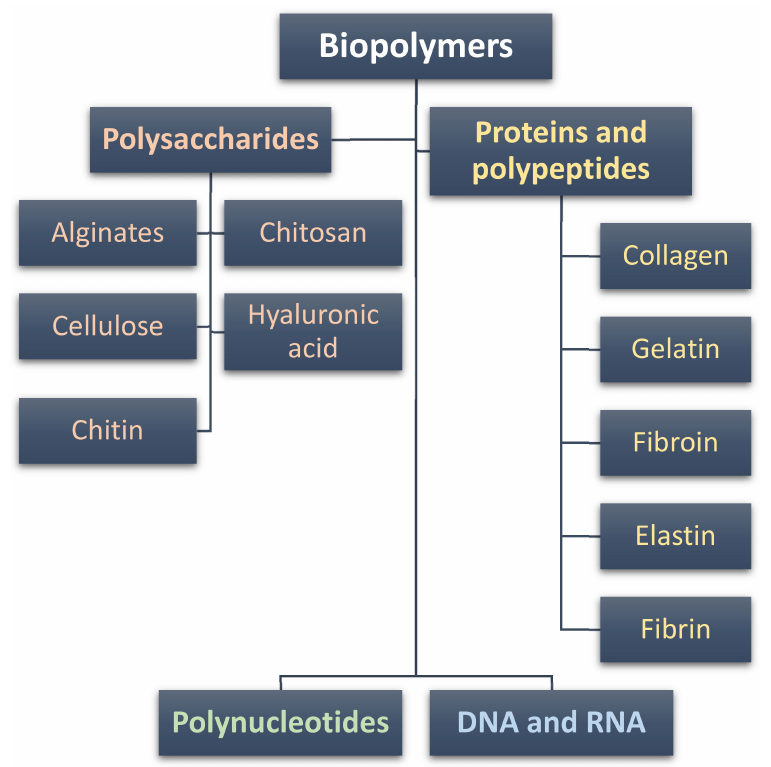
Figure 2. Natural biopolymers that are commonly used to prepare